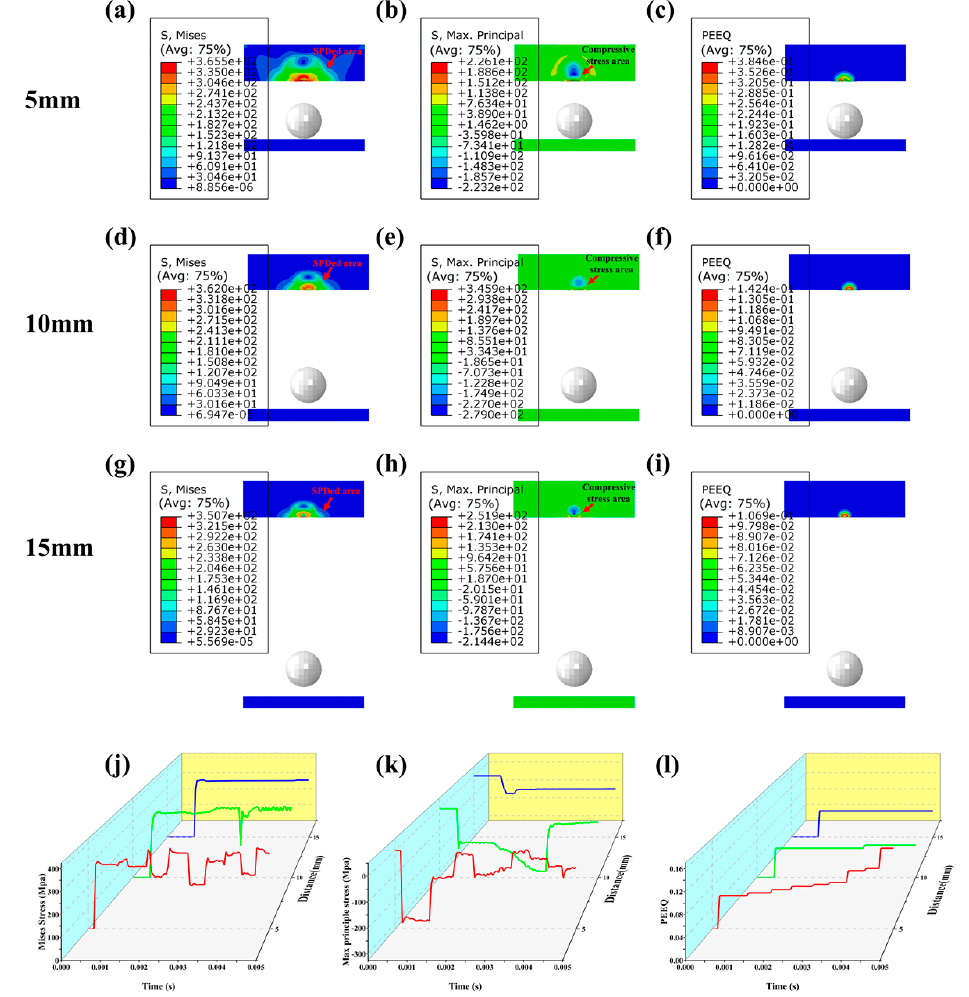
Figure 10. Effect of the working distance on the von Mises stress, maximum principal stress, and plastic strain of 316L stainless steel during the ultrasonic shot peening process: ( a – c ) von Mises stress, maximum principal stress, and plastic strain of 316L stainless steel with USP working distance of 5 mm, respectively; ( d – f ) von Mises stress, maximum principal stress, and plastic strain of 316L stainless steel with USP frequency of 10 mm, respectively; ( e – i ) von Mises stress, maximum principal stress, and plastic strain of 316L stainless steel with USP frequency of 15 mm, respectively; ( i – l ) comparison of von Mises stress, maximum principal stress, and plastic strain of 316L stainless steel with USP frequency of 5 mm, 10 mm and 15 mm,